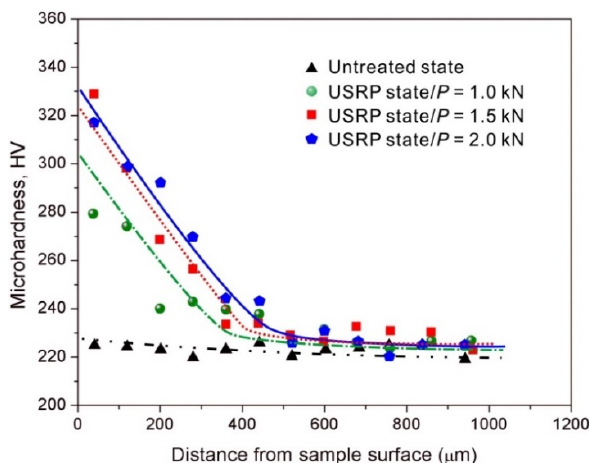
Figure 4. Microhardness distribution along the cross section of the untreated specimen and USRP-treated specimens with different static loads P .